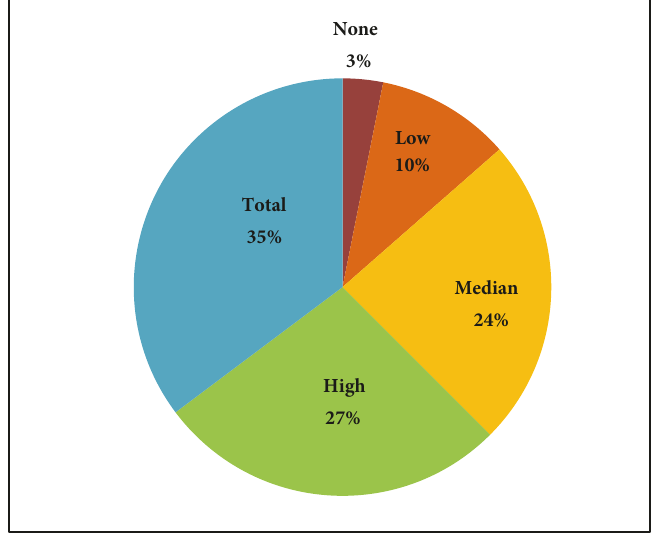
Figure 3: Relative frequency of answers to question 20 of the questionnaire, in terms of level of attention (low, median, or high).